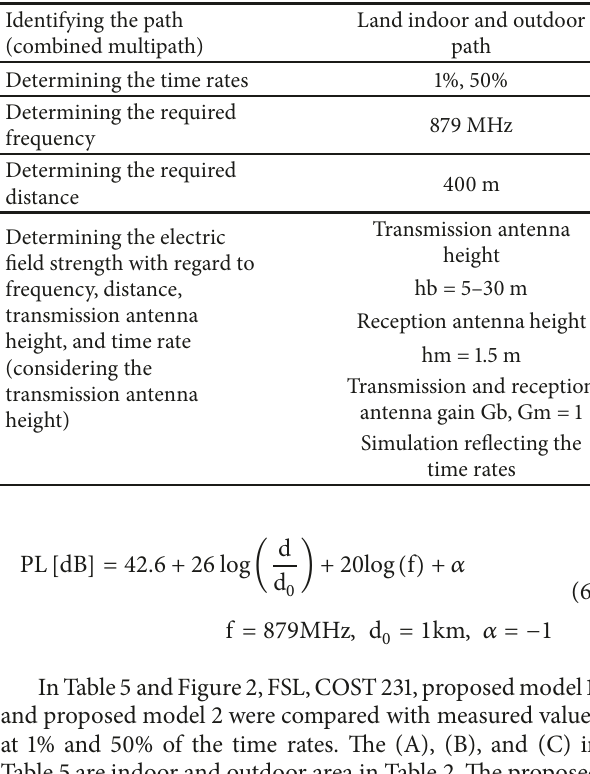
Table 4: The proposed model